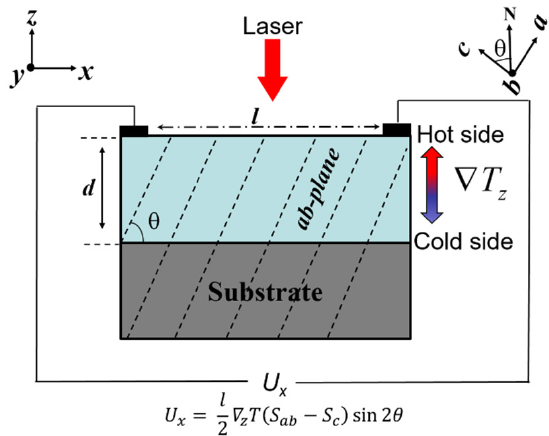
Figure 1. Schematic structure of laser detectors based on the TTE effect of thin films (in blue) grown on vicinal cut substrate (in black).